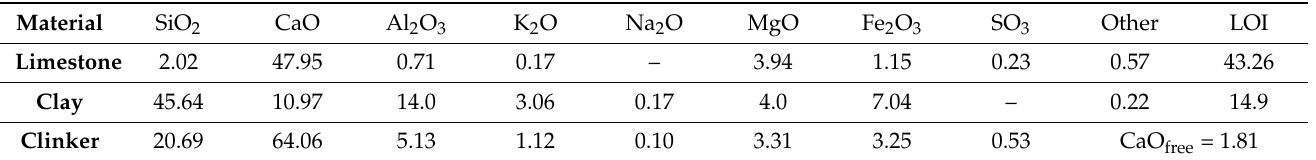
Table 1. Oxide composition of Karpenai limestone, Saltiskiai clay and JSC Akmenes cementas clinker,